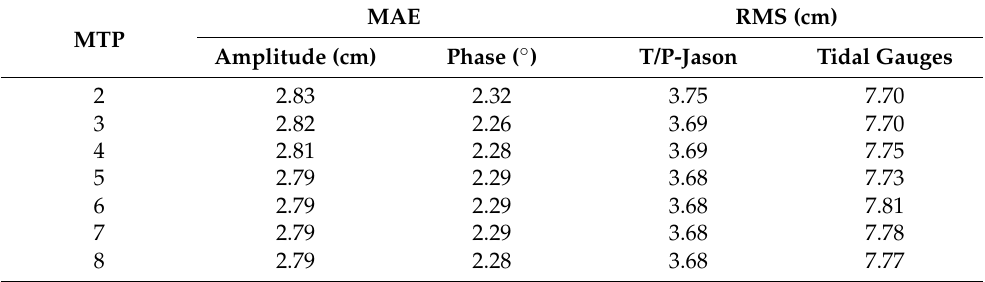
Figure 10. FCs inverted by assimilating T/P-Jason data with MTP of 2 ( a ), 3 ( b ), 4 ( c ), 5 ( d ), 6 ( e ), 7 ( f ), 8 ( g ). Table 3. MAE and RMS errors between simulation and observations in the practical experiment.